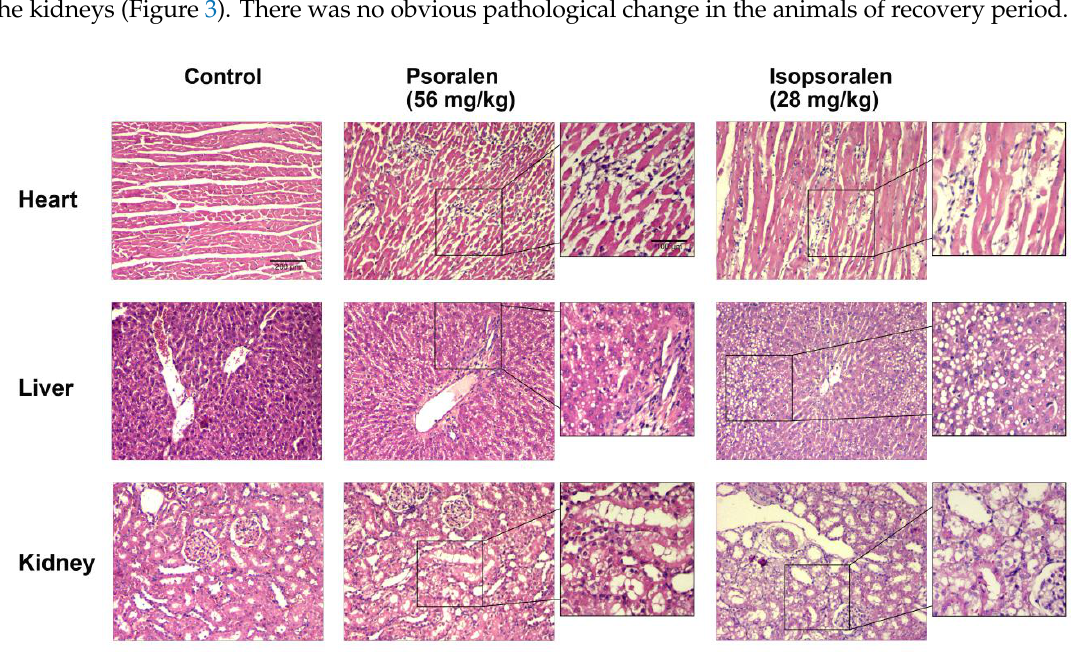
Figure 3. Histopathological photographs of organ lesions in Sprague–Dawley (SD) rats. H & E staining showing the heart, liver, and kidney injuries induced by psoralen and isopsoralen, 100× and 200×.